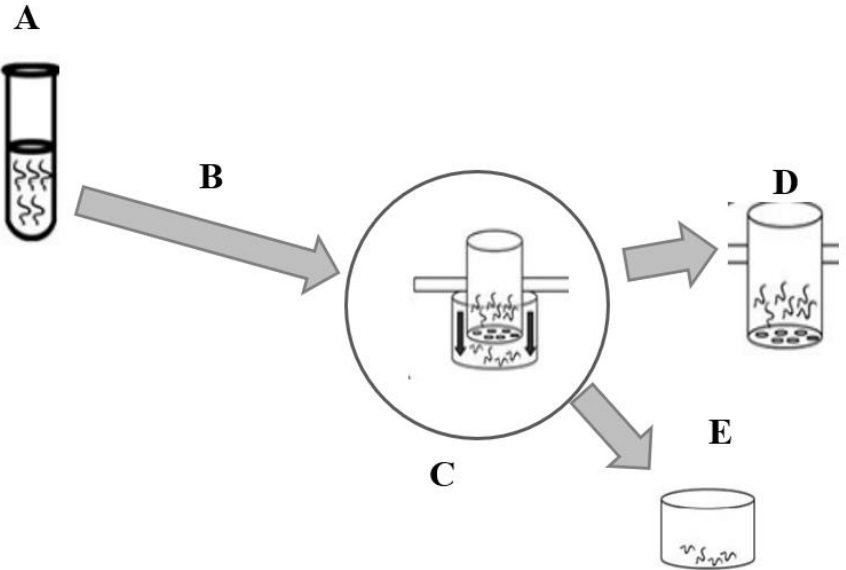
Figure 2. Larval migration inhibition assay (LMIA) illustration. ( A ) Incubation of infective larvae (L3) with controls and extracts at different concentrations for 3 h (25 °C). ( B ) Successive washing (3 times) of incubated larvae by centrifugation (67× g ) with phosphate buffered saline (PBS). ( C ) Transfer of washed larvae to inserts (20 µm diameter) for migration. ( D ) After 3 h, the larvae in the inserts were discarded. ( E ) Larvae count in the conical tube at the bottom of the inserts. Source: adapted from Zarate Rendon [32].